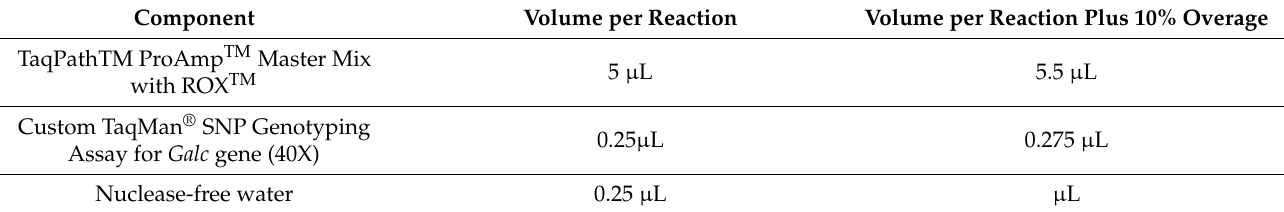
Table 2. Components and volume of the PCR